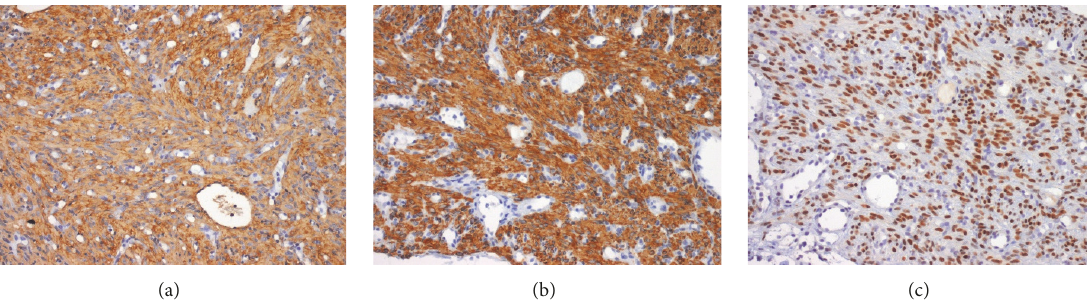
Figure 4: Immunohistochemical staining of BML and uterine leiomyoma of patient 2. (a) SMA, (b) Desmin, and (c) Hormonal Receptors.